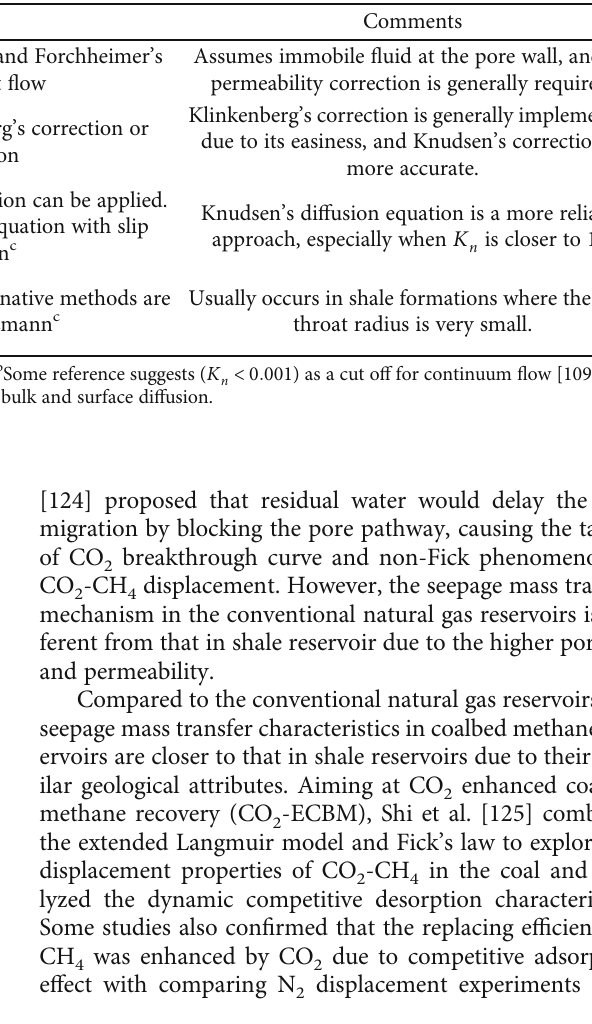
Figure 5: Multiscale migration mechanism of gas in shale [52]. Table 3: Characteristics of various fl ow regime under di ff erent Knudsen number